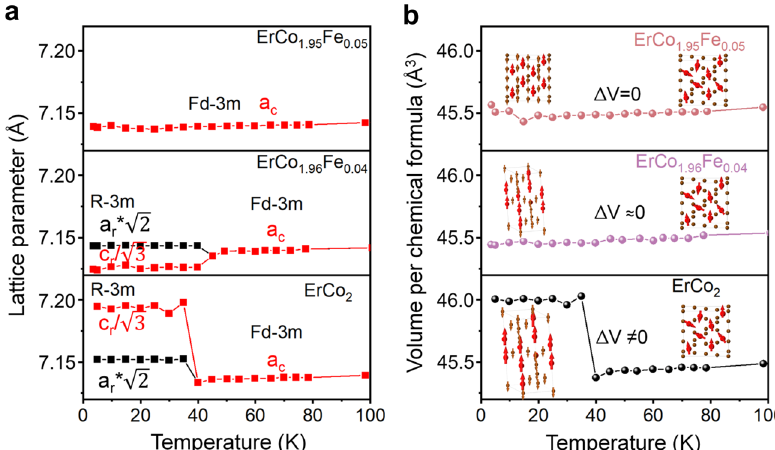
Fig. 3 Analysis of the lattice constant and crystal volume change around the transition temperature range using cryogenic x-ray diffraction (XRD). a Temperature dependence of the lattice parameters for ErCo 2 -based alloys. The lattice parameters are obtained from the Rietveld re fi nement. The lattice parameters of the rhombohedral phase are plotted for b Temperature-dependent volume per chemical formula for ErCo 2 (black), ErCo 1.96 Fe 0.04 (purple) and ErCo 1.95 Fe 0.05 (red) alloys, the crystal structure change upon transition is also illustrated by a unit cell (red and brown spheres represent Er and Co atoms, respectively, and red and brown arrows represent the magnetic moments of the Er and Co atoms,